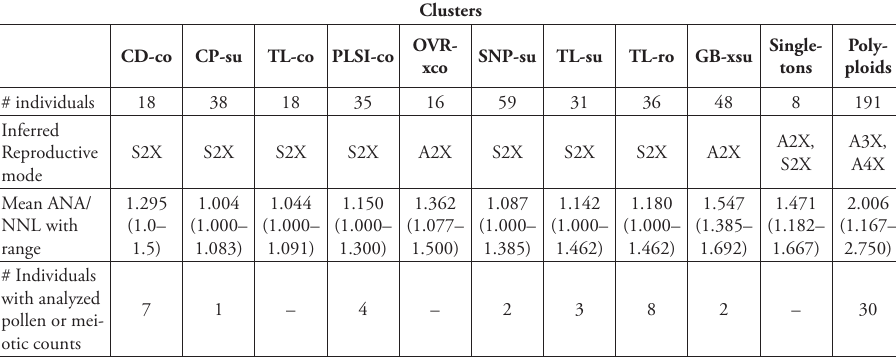
Table 1. Summary of sexual diploid (S2X), apomictic diploid (A2X), and apomictic polyploid (A3X and A4X) assignments and clusters inferred from preliminary analyses. Polyploids, A2X clusters, and single- tons were excluded from the final S2X analyses (see